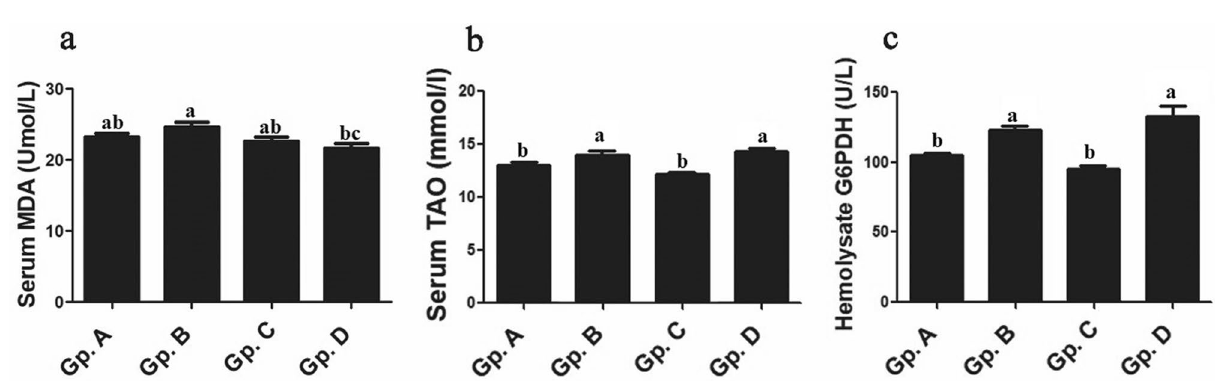
Figure 8. Effect of temperature changes on serum lipid peroxidation, total antioxidant capacity, and G6PDH (as an antioxidant enzyme) activity ( a : MDA; b : TAO; c : G6PDH) in Dabb lizard ( U. aegyptia ). Data were expressed as mean ± SE. Gp. A: control group; Gp. B: low temperature exposed group; Gp. C: moderate temperature exposed group; Gp. D: high temperature exposed group; G6PDH: glucose-6-phospate dehydrogenase; TAO: total antioxidant; MDA: malondialdehyde. abc Means above each bar with different letters in different Dabb groups i.e. Gp. A, Gp. B, Gp. C and Gp. D, were significantly different ( P < 0.05).